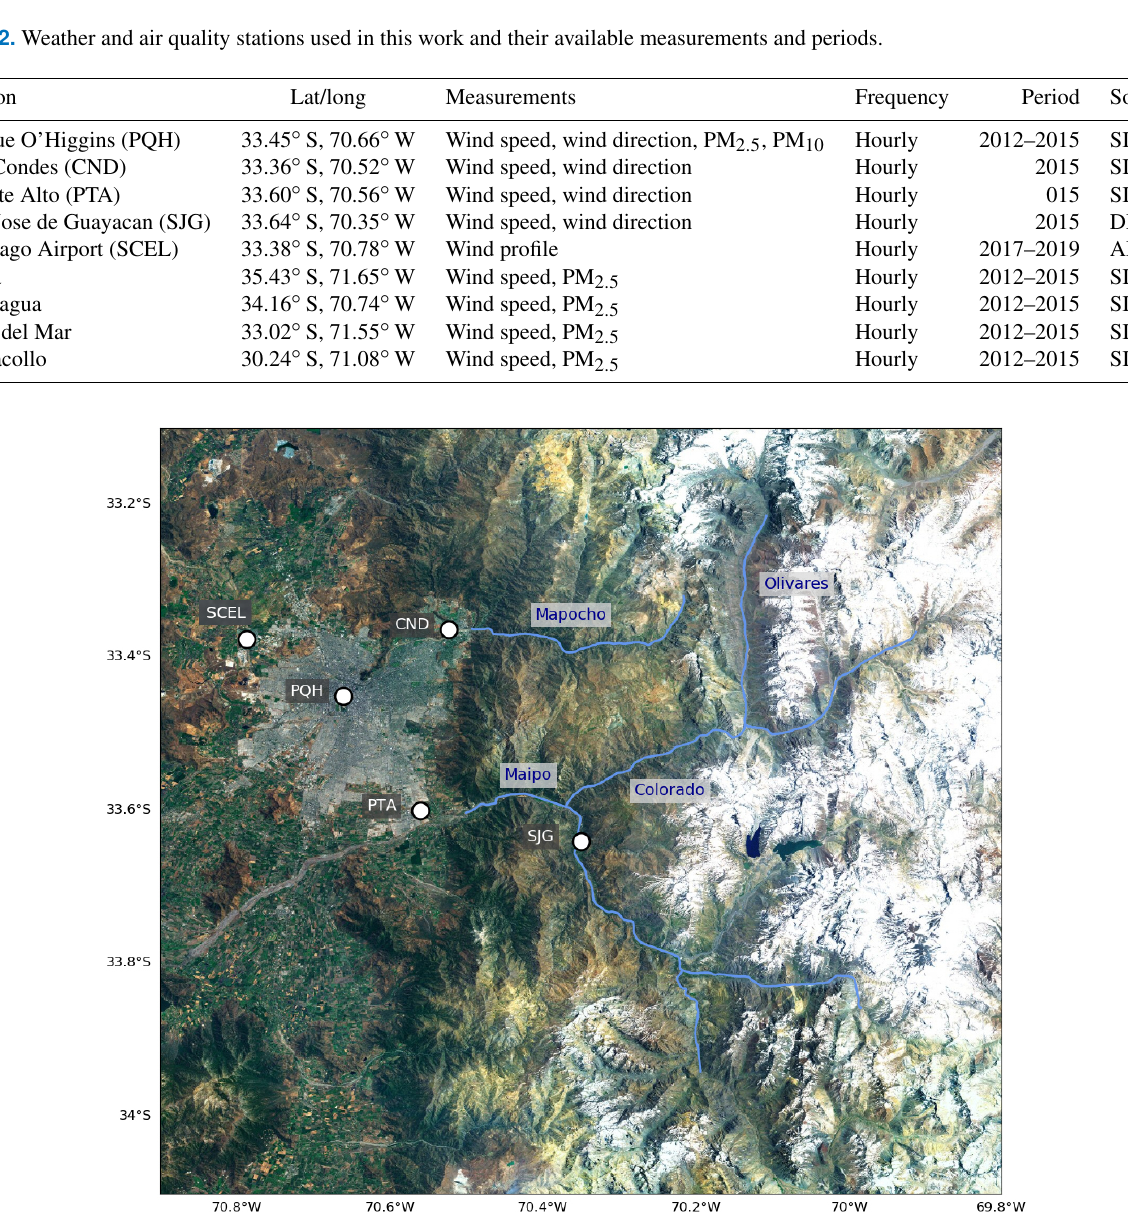
Figure 1. Localities and canyons of interest in the vicinity of Santiago. Measurement stations are designated with white circles. Canyons of interest are evidenced with blue lines. Map background layer source: Imagery World 2D, © 2009